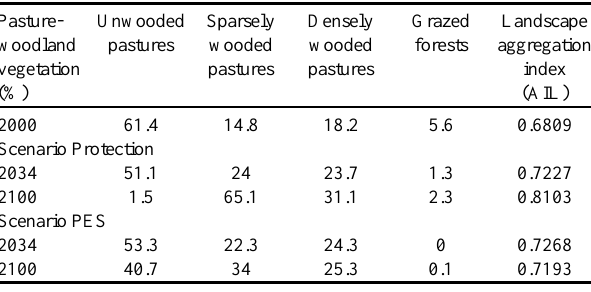
Table 3 . Percentage of pasture woodland vegetation types and landscape aggregation index in 2000, 2034, and 2100 in the two policy scenarios for Planets-Cluds (1200 m a.s.l. intensive use). PES = Payment for environmental services.